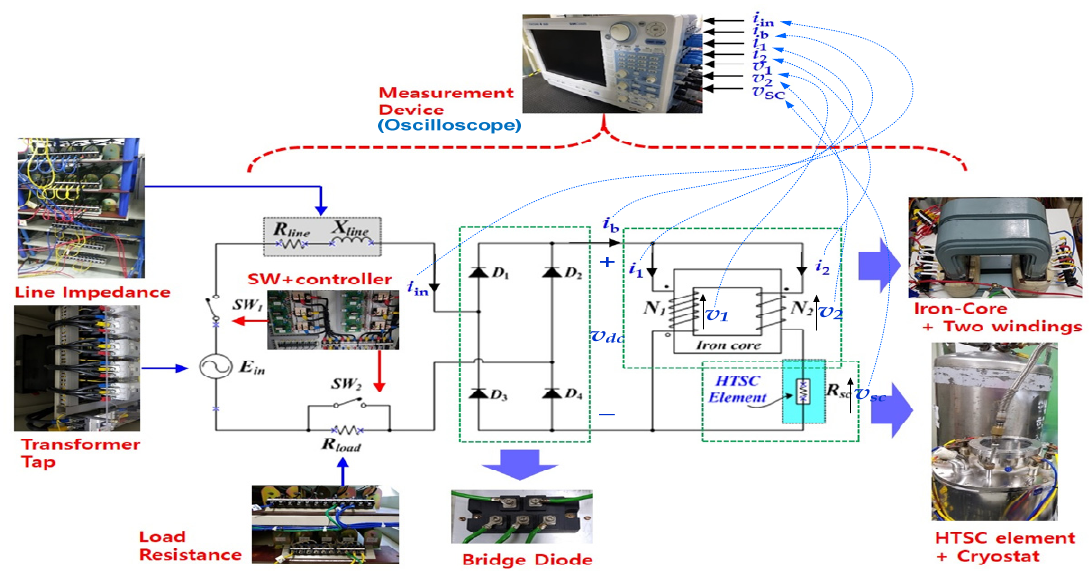
Figure 3. Short-circuit test of bridge type SFCL with a single HTSC element using flux-coupling.